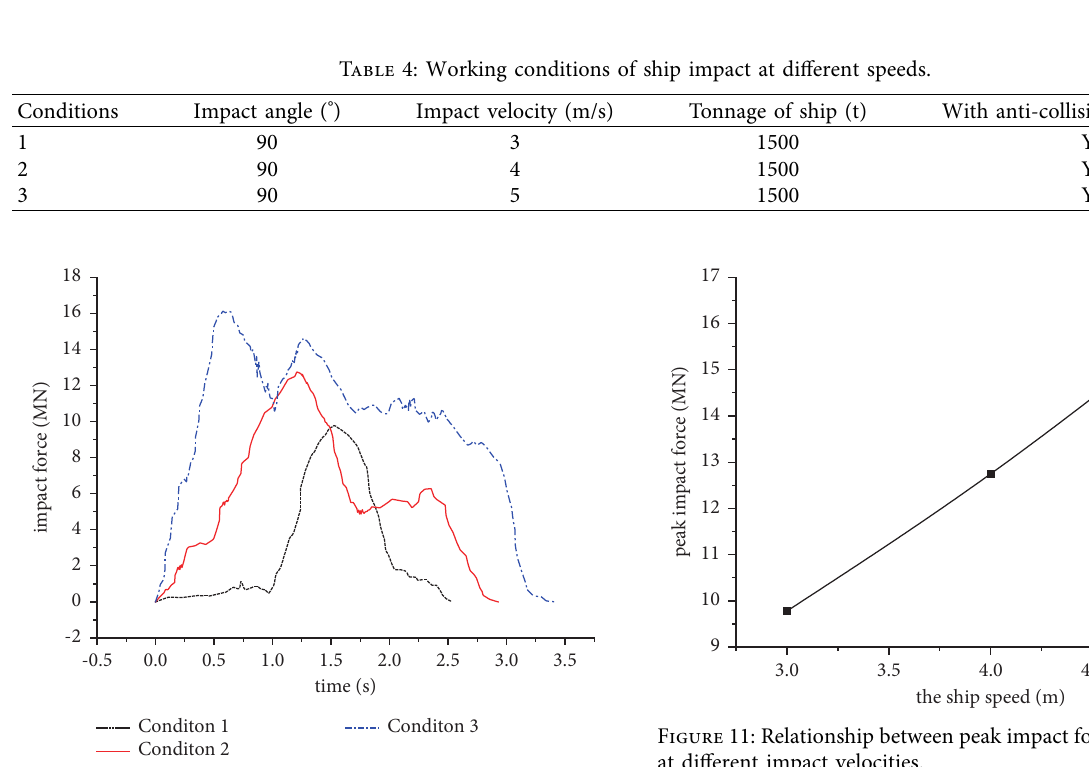
Figure 10: Time of collision force when ships at different speeds collide with piers with protective devices.